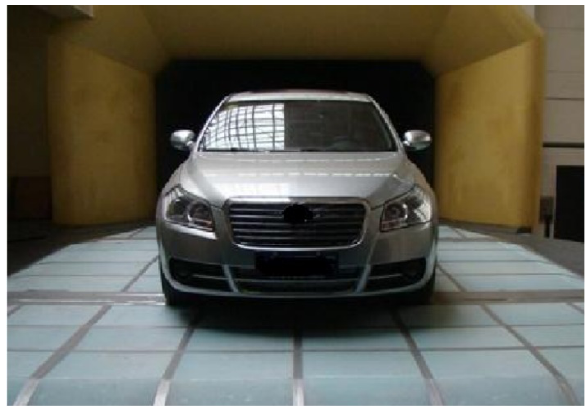
Figure 2. Test layout.